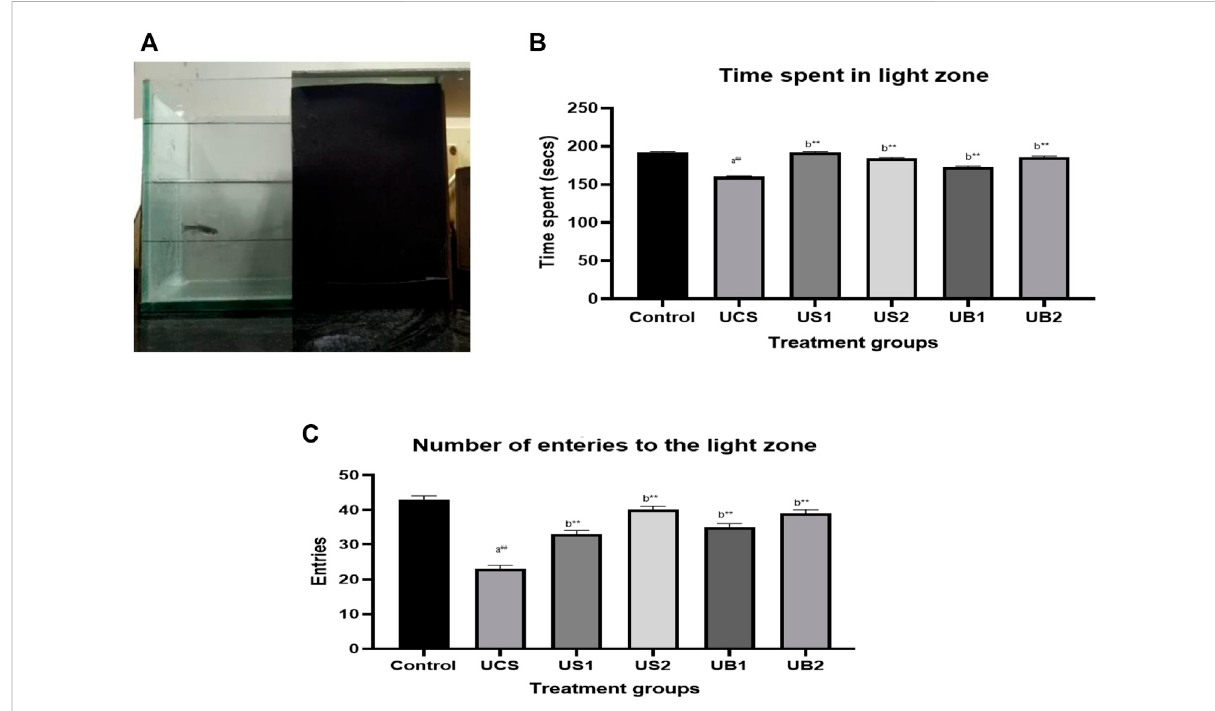
FIGURE 7 (A) Light dark test of drug-treated group of zebra fi sh (UCS) (B) The effect of treatment on the time spent in the light zone of the tank (UCS) (C) The effect of treatment on entries to the light zone of the tank (UCS). The data are presented as the mean ± S.E.M. A one-way ANOVA followed by a Bonferroni post hoc test was used ( n = 8 – 10). (A) Comparisons were made between the stressed group (UCS) with the normal control. (B) Comparisons were made between US1, US2, UB1 and UB2 with the stressed group (UCS). p-value ***represents p < 0.001, **represents p < 0.01, *represents p < 0.05, ## represents p <